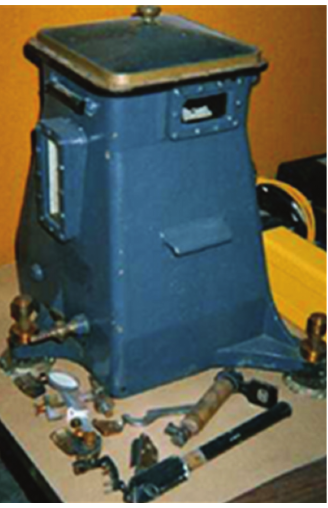
Figure 1: The Mendenhall pendulum.